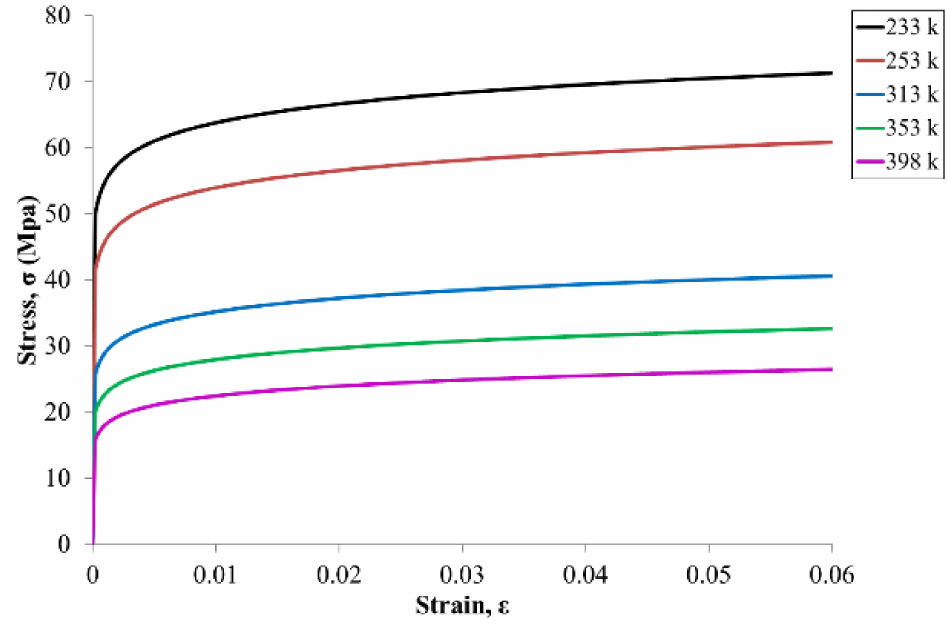
Figure 5. Stress–strain curves of Sn–3Ag–0.5Cu solder balls at different